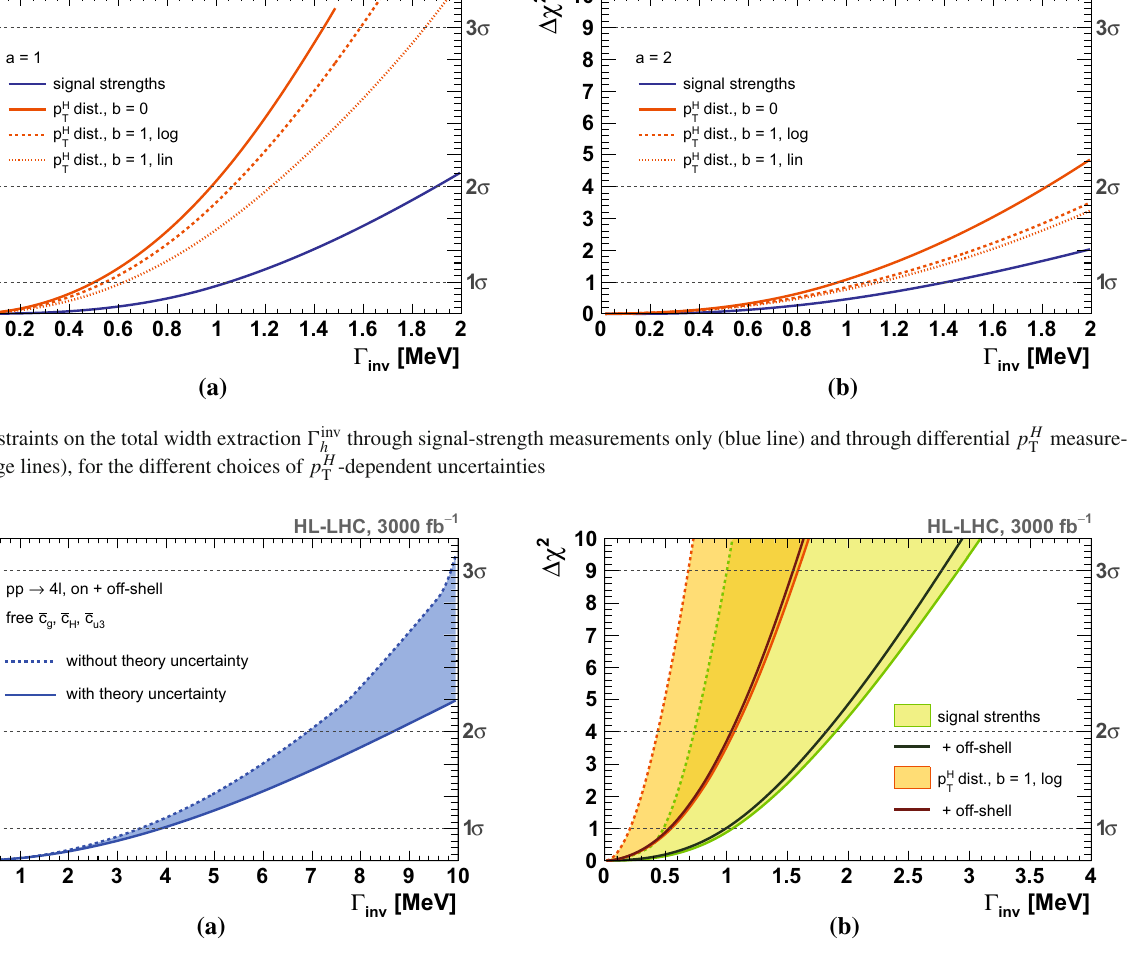
ments. The choice of a = 1 is made for the theoretical uncertainties and their impact is depicted as coloured